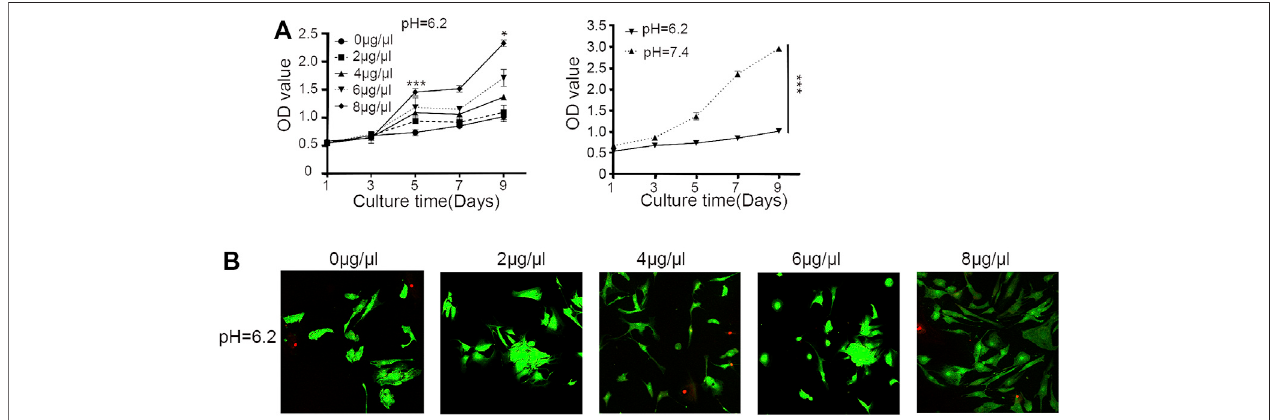
FIGURE3| Sa12balleviatedtheproliferationinhibitionofNP-MSCsinaseverelyacidicenvironment. (A) TheproliferationofNP-MSCsinanacidicenvironment( pH = 6.2) was signi fi cantly lower than normal ( pH = 7.4). When different concentrations of Sa12b (0, 2, 4, 6, and 8 μ g/ μ l) were added, the proliferation inhibition of human degenerated NP-MSCs was signi fi cantly improved ( p < 0.05). * p < 0.05 indicated statistical difference between the groups; *** p < 0.001 indicated signi fi cant difference between groups. (B) Live and dead cell imaging of NP-MSCs treated with different concentrations of Sa12b. The green fl uorescent cells are the live cells labeled with CAM, and the red fl uorescent cells are the dead cells labeled with